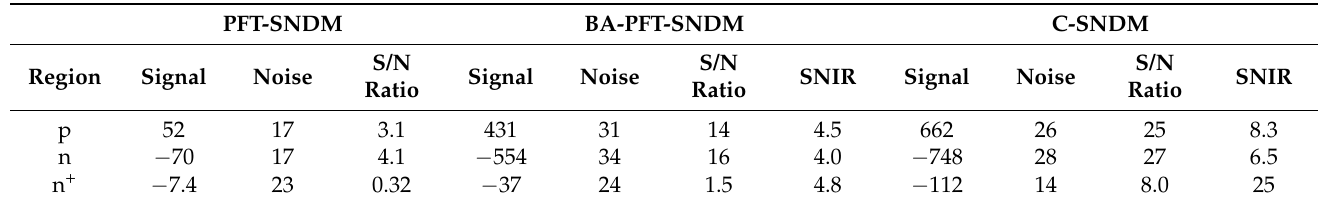
Table 1. Signal intensity in Hz pk /V pk , noise levels in Hz rms /V pk , and S/N ratios in different imaging modes. SNIRs indicates S/N ratio normalized by those in PFT-SNDM. BA-PFT-SNDM